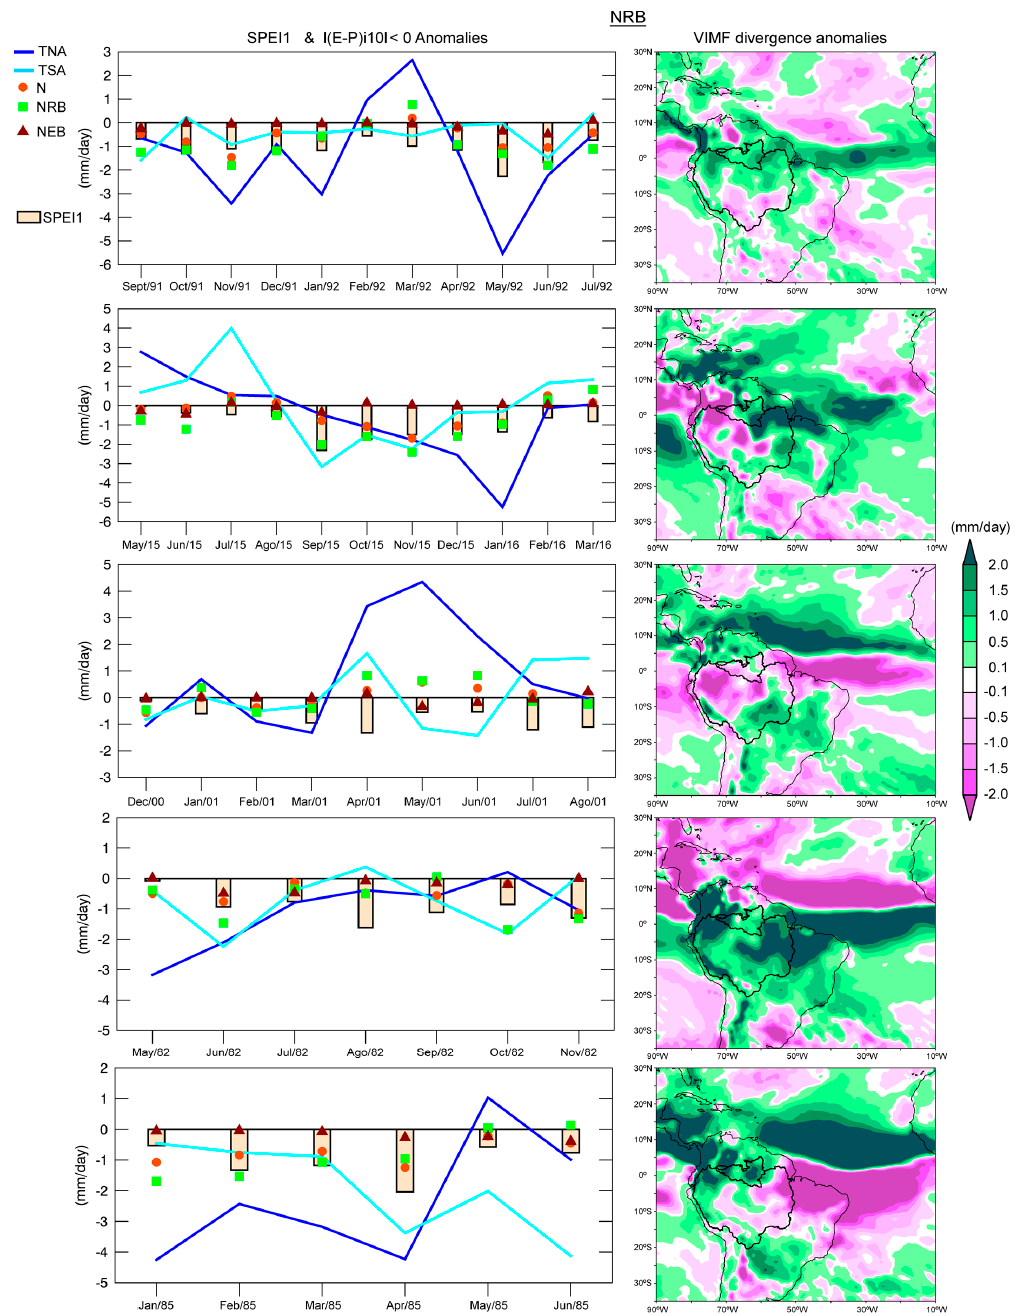
Figure 12. The SPEI1 and monthly anomalies of | (E – P)i10 < 0| during the most severe dry episodes (left panel) in the NRB (ordered as in Table 4) and VIMF divergence anomalies for each episode (right panel).